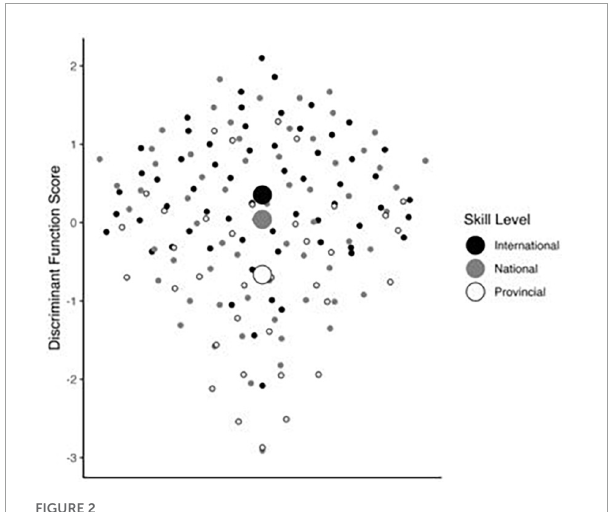
FIGURE2 Discriminant function analysis (previously unreported) performed on data from Wilson et al. (2021b), in a sample restricted to high performance athletes ranging from provincial to international level. Small points represent discriminant function scores (i.e., the linear combination of relevant SRL processes) for each participant, varying on the y-axis and visually distributed on the x-axis. Large points represent group centroids for each of the skill level groups.